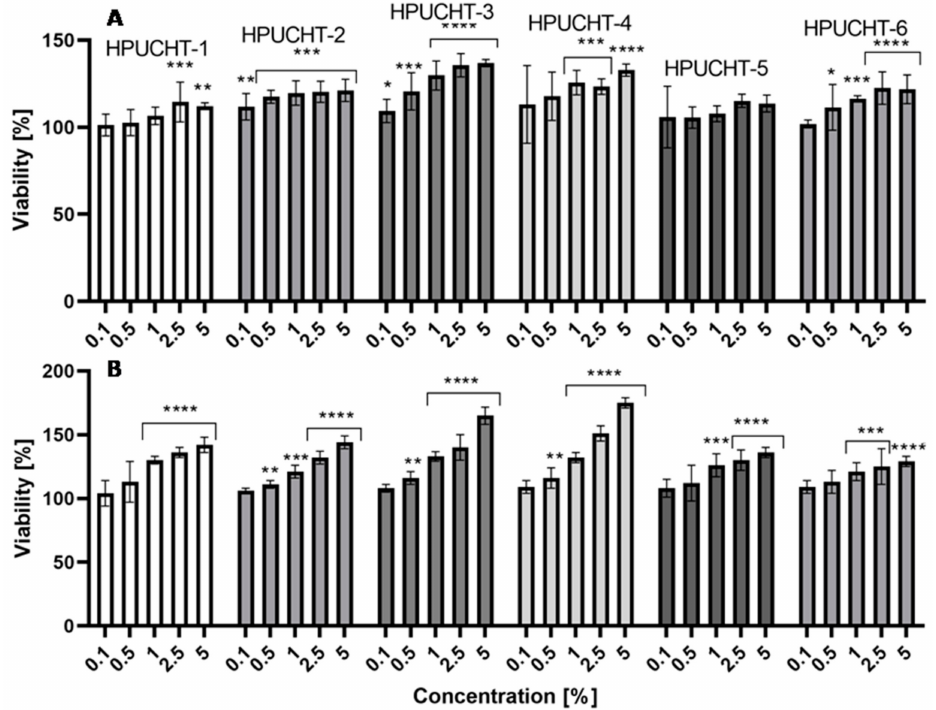
Figure 5. Thereduction of resazurin after 2 h ( A ) and 24 h ( B ) of exposure to extracts (0.1–5%) from hydrogels in cultured fibroblasts. **** p ≤ 0.0001, *** p ≤ 0.001, ** p ≤ 0.01, * p ≤ 0.05 versus the control